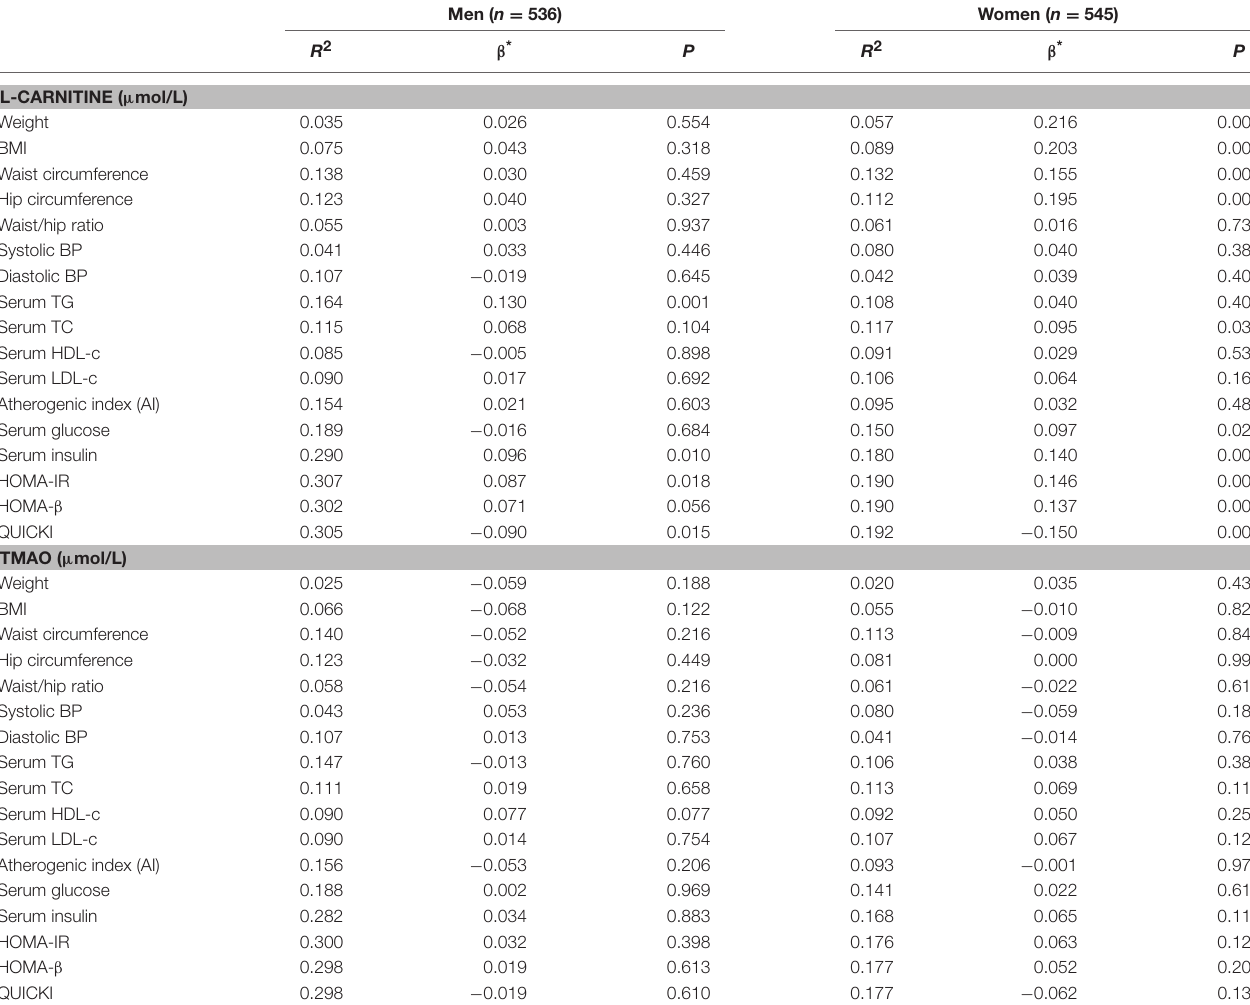
TABLE 3 | Linear Regression analysis of serum L-carnitine, TMAO levels with metabolic syndrome related indexes a